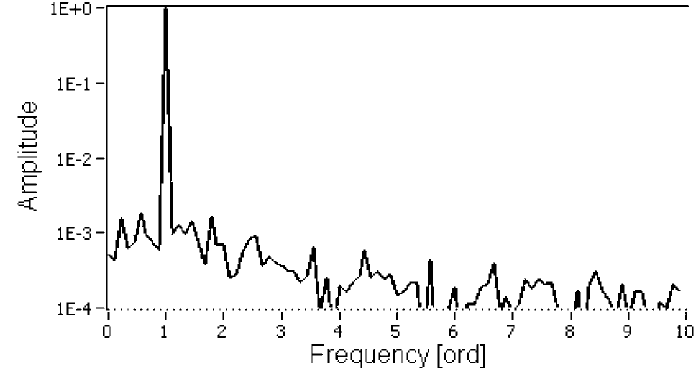
Fig. 13. Order spectrum of varying random acceleration.